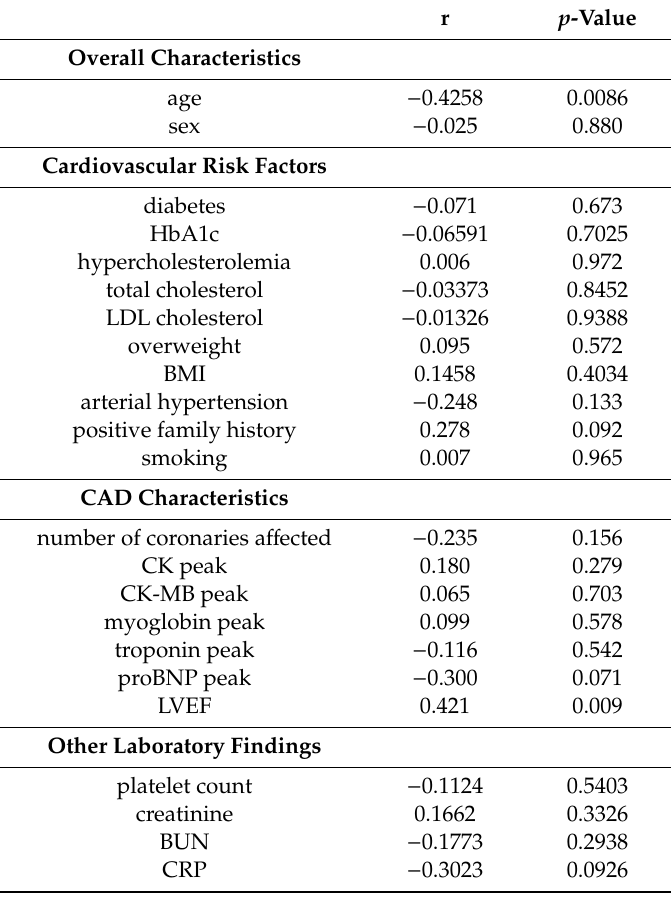
Table 3. Correlation